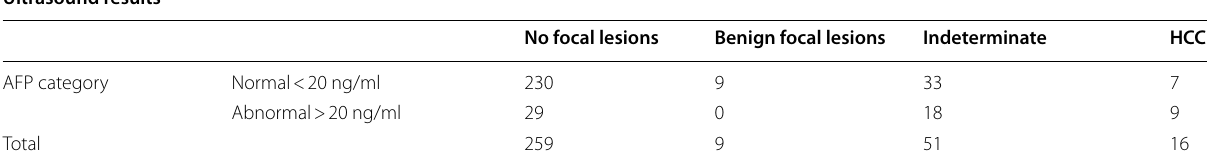
Table 2 Distribution of US results among AFP categories Ultrasound